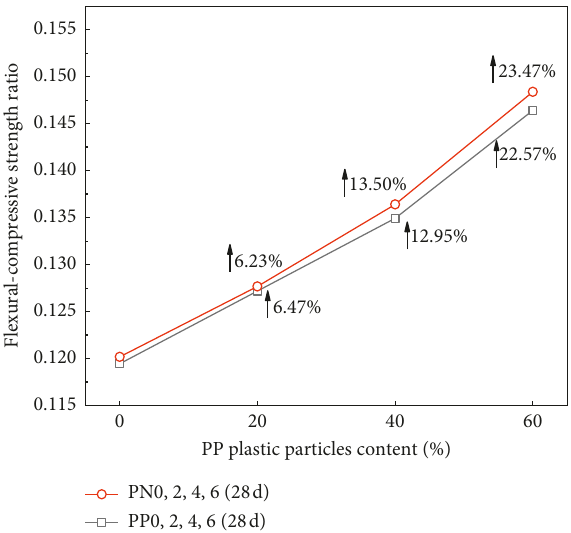
Figure 8: Evolution of the flexural-compression ratio of mortars as function of plastic waste content.